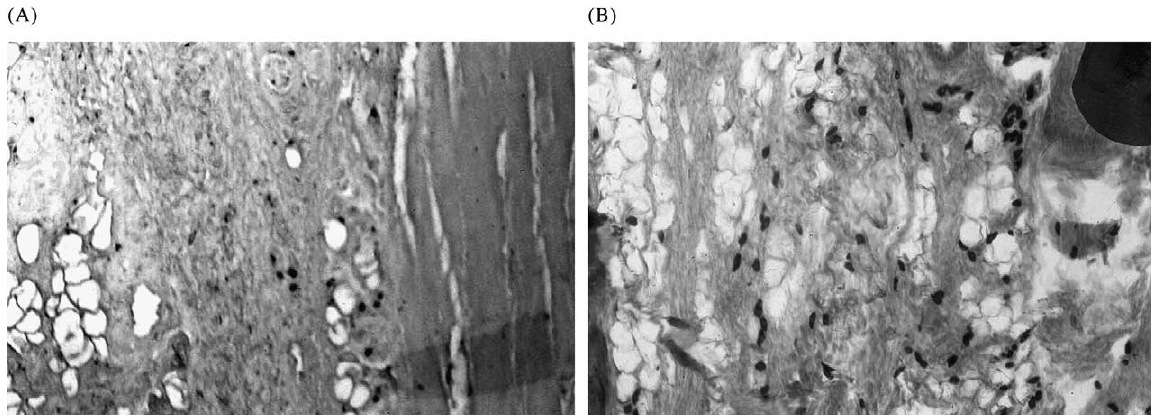
FIG. 7. (A) Three weeks after tendon injury in an untreated wound in the rat ( (cid:4) / 10, 5-bromo-4-chloro-3 indolyl phosphate/nitro- blue tetrazolium) showing small numbers of macrophages (labelled with the macrophage marker ED1) in the subcutaneous tissue. (B) Four weeks after tendon injury in L-NAME-treated rats ( (cid:4) / 40, 5-bromo-4-chloro-3 indolyl phosphate/nitro-blue tetrazolium) showing increased numbers of macrophages (labelled with the macrophage marker ED1) in the subcutaneous tissue. Macrophages are larger than those in the control injury